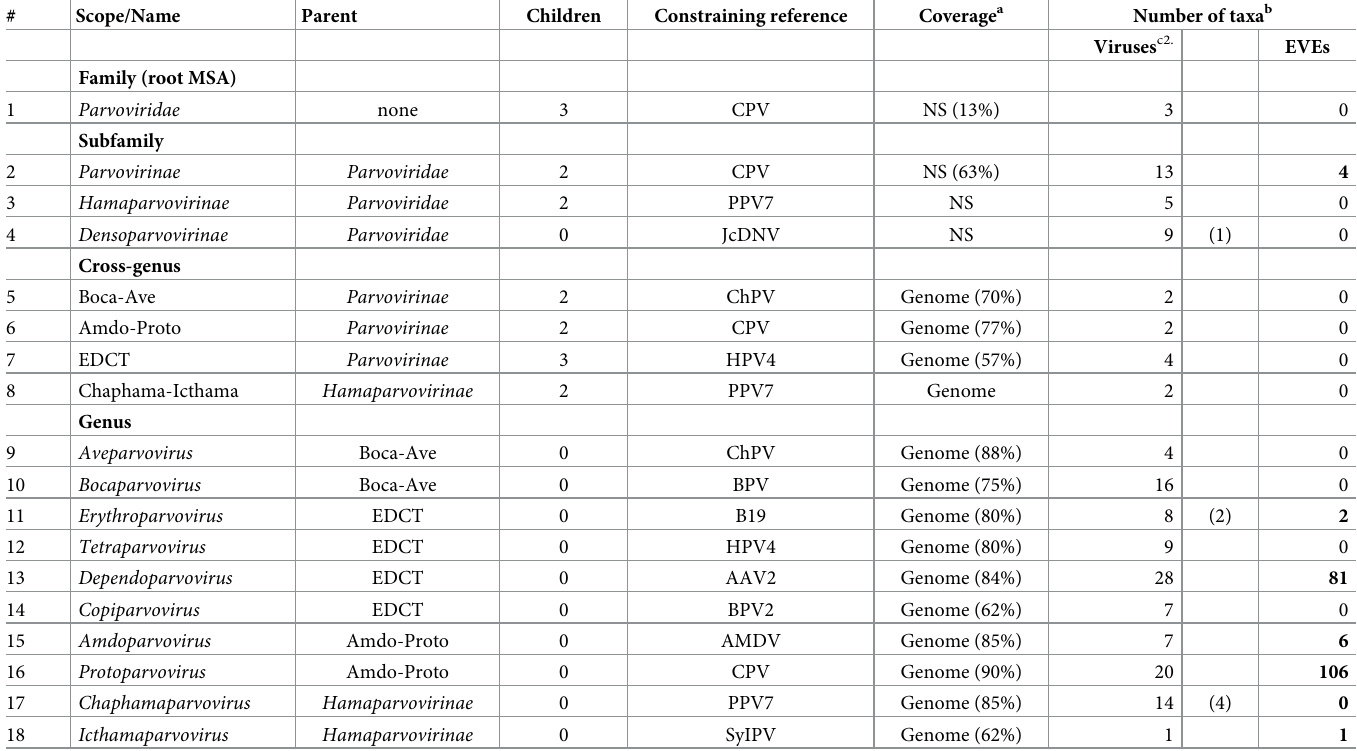
Table 1. Summary of MSA hierarchy constructed for the family Parvoviridae